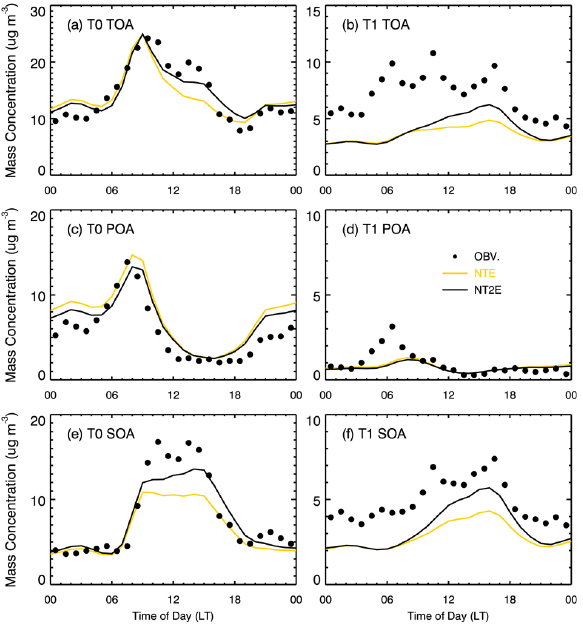
Figure 11 Fig. 11. Same as Fig. 5, except that the brown line represents the NTE-SOA model (without OH feedback) and the black line denotes the NT2E-SOA model (without OH feedback).